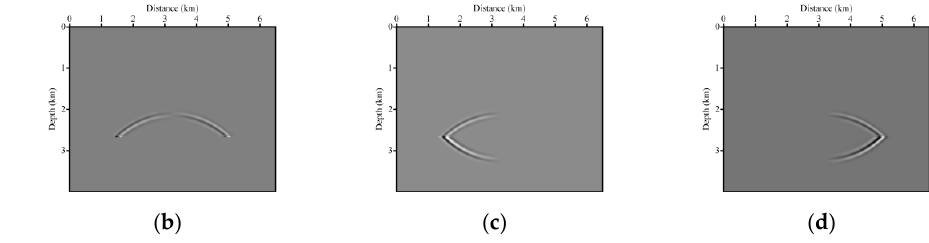
Figure 7. Filtered wavefield: ( a ) downgoing; ( b ) upgoing; ( c ) Leftgoing; ( d ) rightgoing.